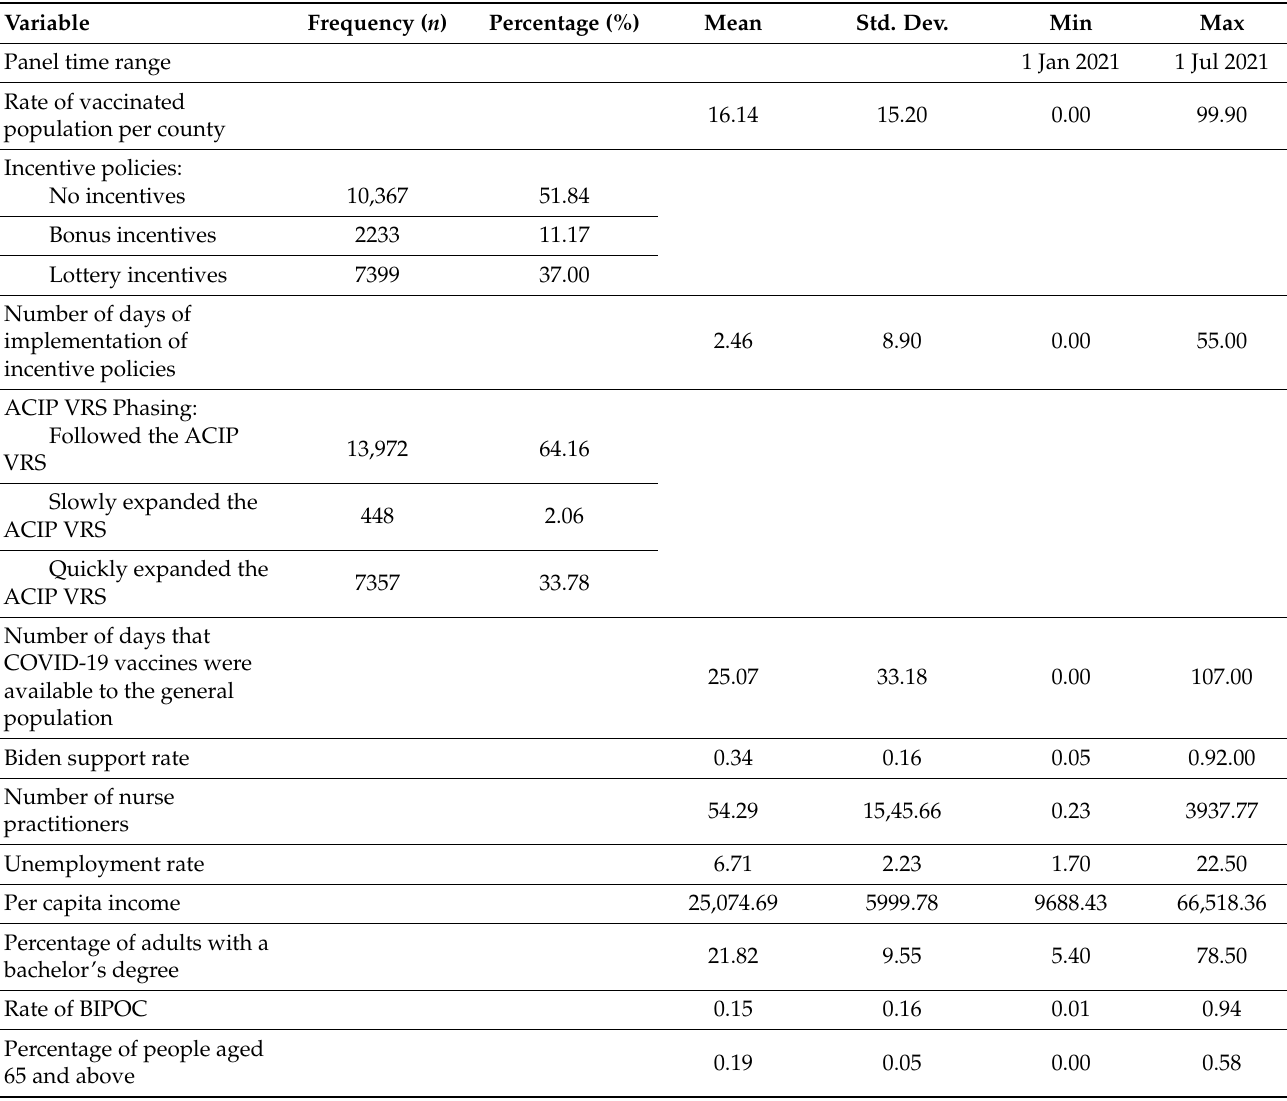
Table 1. Descriptive statistics of COVID-19 vaccination incentive policies and socioeconomic factors at the county